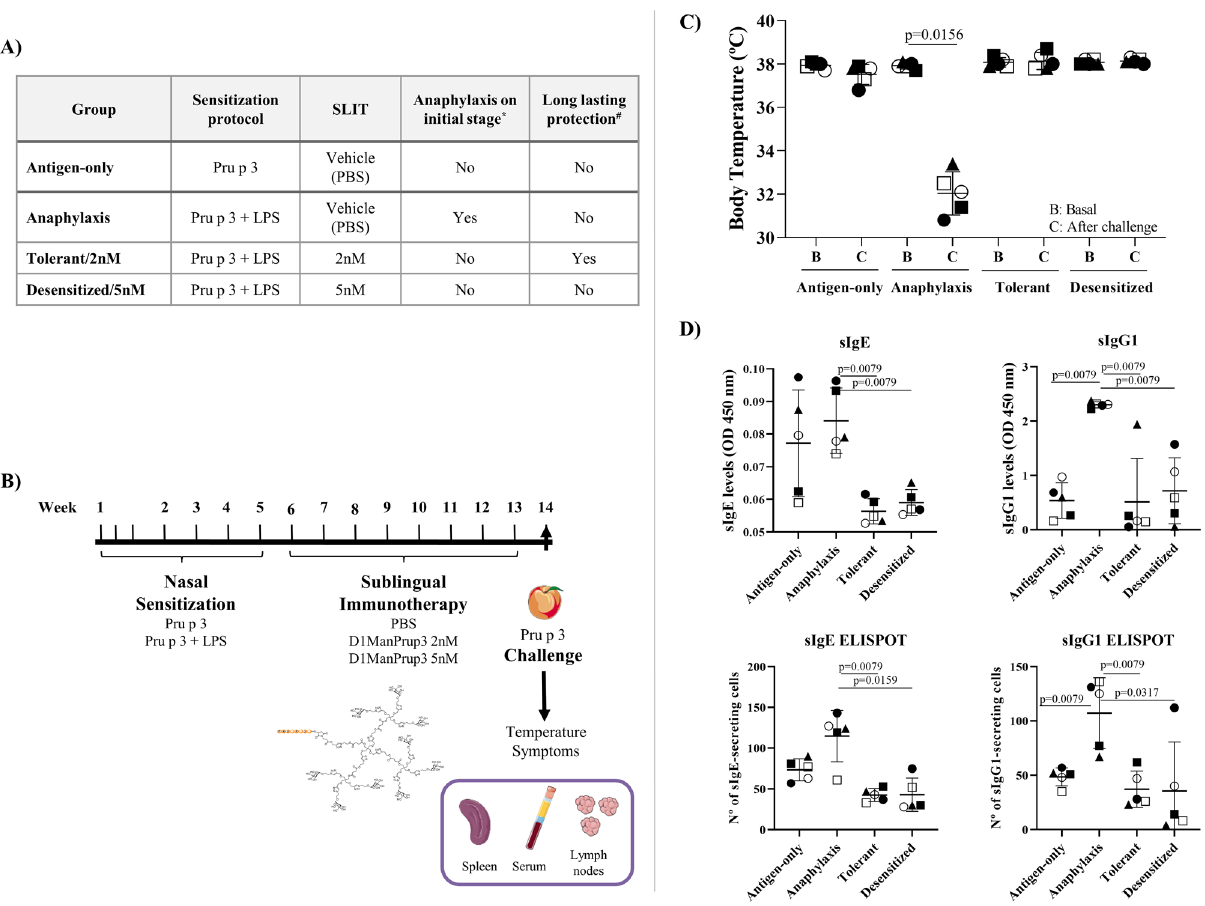
Figure 1. Experimental overview and physiological/immunological changes in the different groups. ( A ) Details of the sensitization and sublingual immunotherapy treatment for the different groups. *Challenge performed 1 week (1w) after the end of SLIT; #Were the challenge to be performed 5 weeks after the end of SLIT, as shown previously. ( B ) Overview of the experimental design in which mice were sensitized with Pru p 3 (Antigen-only) or Pru p 3 + LPS (additional three groups), then underwent sublingual immunotherapy, before being challenged one week after finishing treatment. ( C ) In vivo evaluation of anaphylaxis after SLIT with D 1 ManPrup3. Dots show decreases in body temperature 30–40 min after challenge with Pru p 3, 1w after ending the SLIT.. The individuals used for the subsequent RNA analysis are marked in black. ( D ) In vitro evaluation after SLIT with D 1 ManPrup3. Bars represent the mean serum level of Pru p 3-sIgE and -sIgG1 by ELISA in different groups (upper part) and the number of Pru p 3-specific IgE and IgG1 secreting cells by ELISpot assay for each group (lower part). Dots represent individual cases. Significant differences when P < 0.05 compared to Anaphylaxis group. The individuals used for the subsequent RNA analysis are marked in